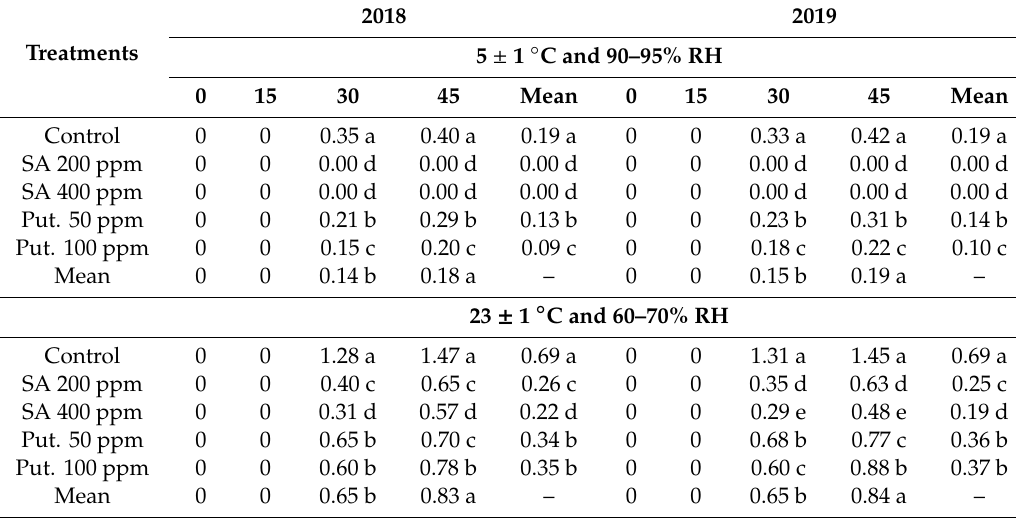
Table 3. E ff ect of salicylic acid (SA) and putrescine (Put) on decay (%) of Murcott mandarin fruit at 15, 30, and 45 days of storage during 2018 and 2019